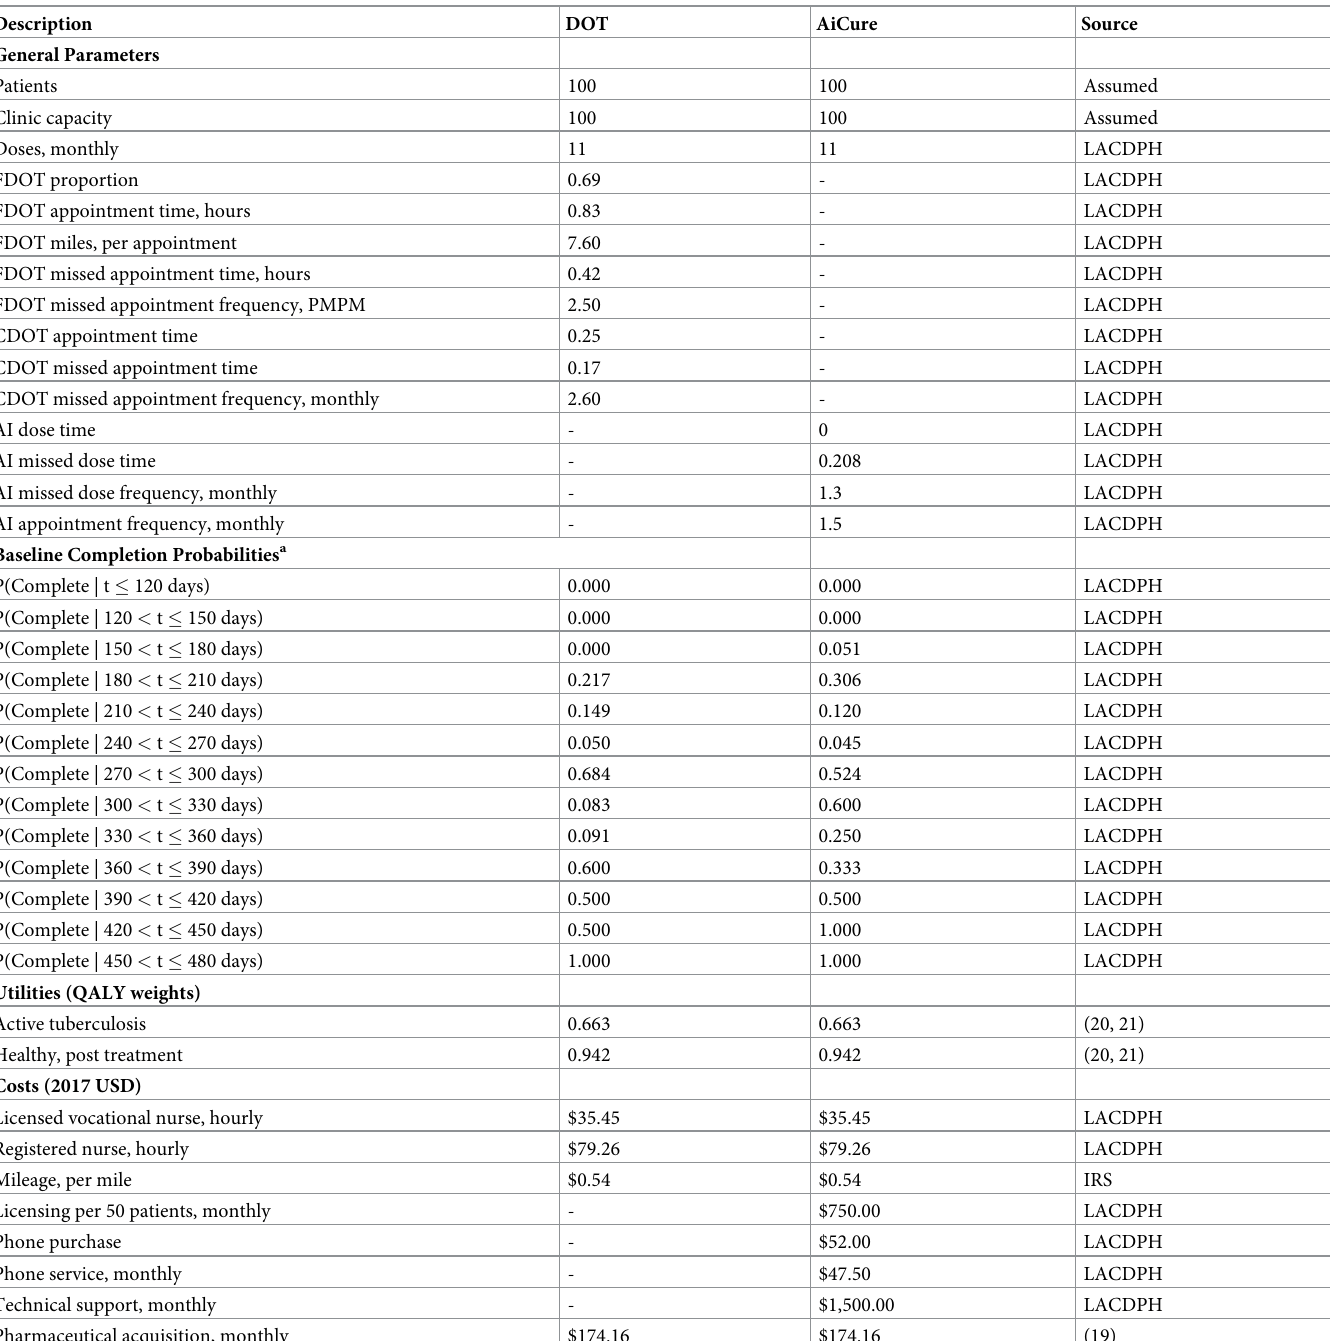
Table 2. Baseline model